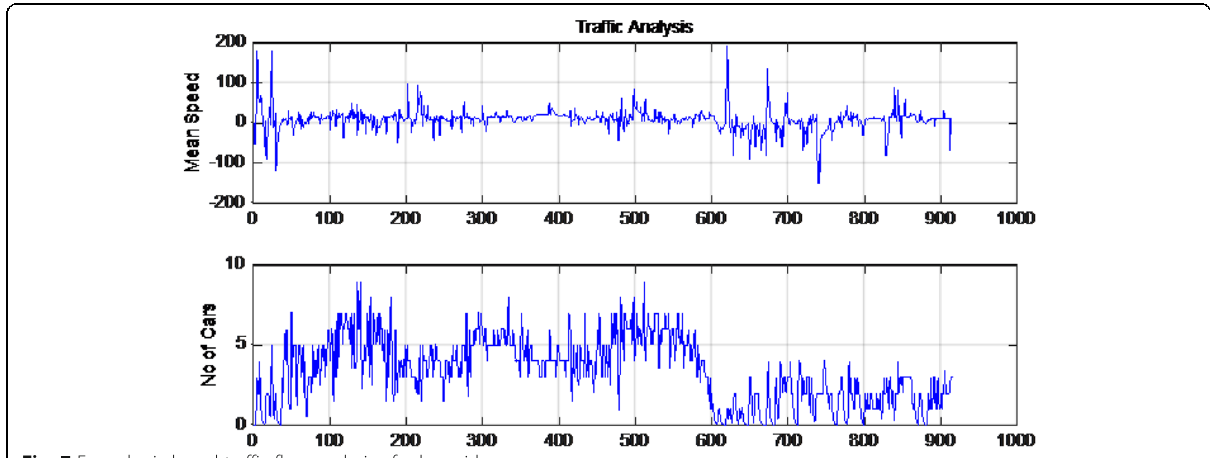
Fig. 7 Fuzzy logic-based traffic flow analysis of urban video